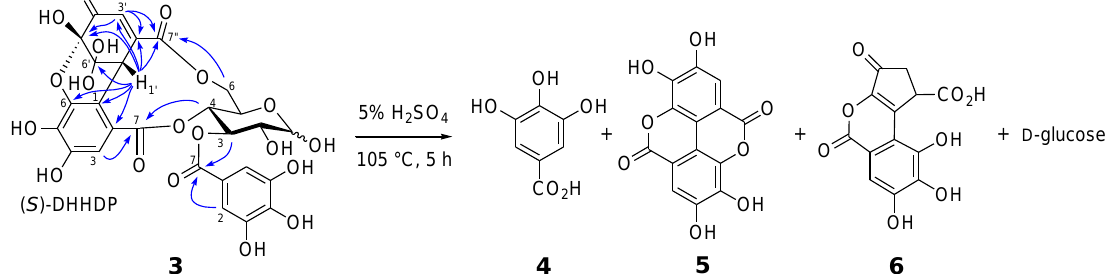
Figure 3. Selected heteronuclear multiple bond coherence (HMBC) correlations and acid hydrolysis of 3- O -galloyl-4,6-( S )-DHHDP- D -glucose ( 3 ).